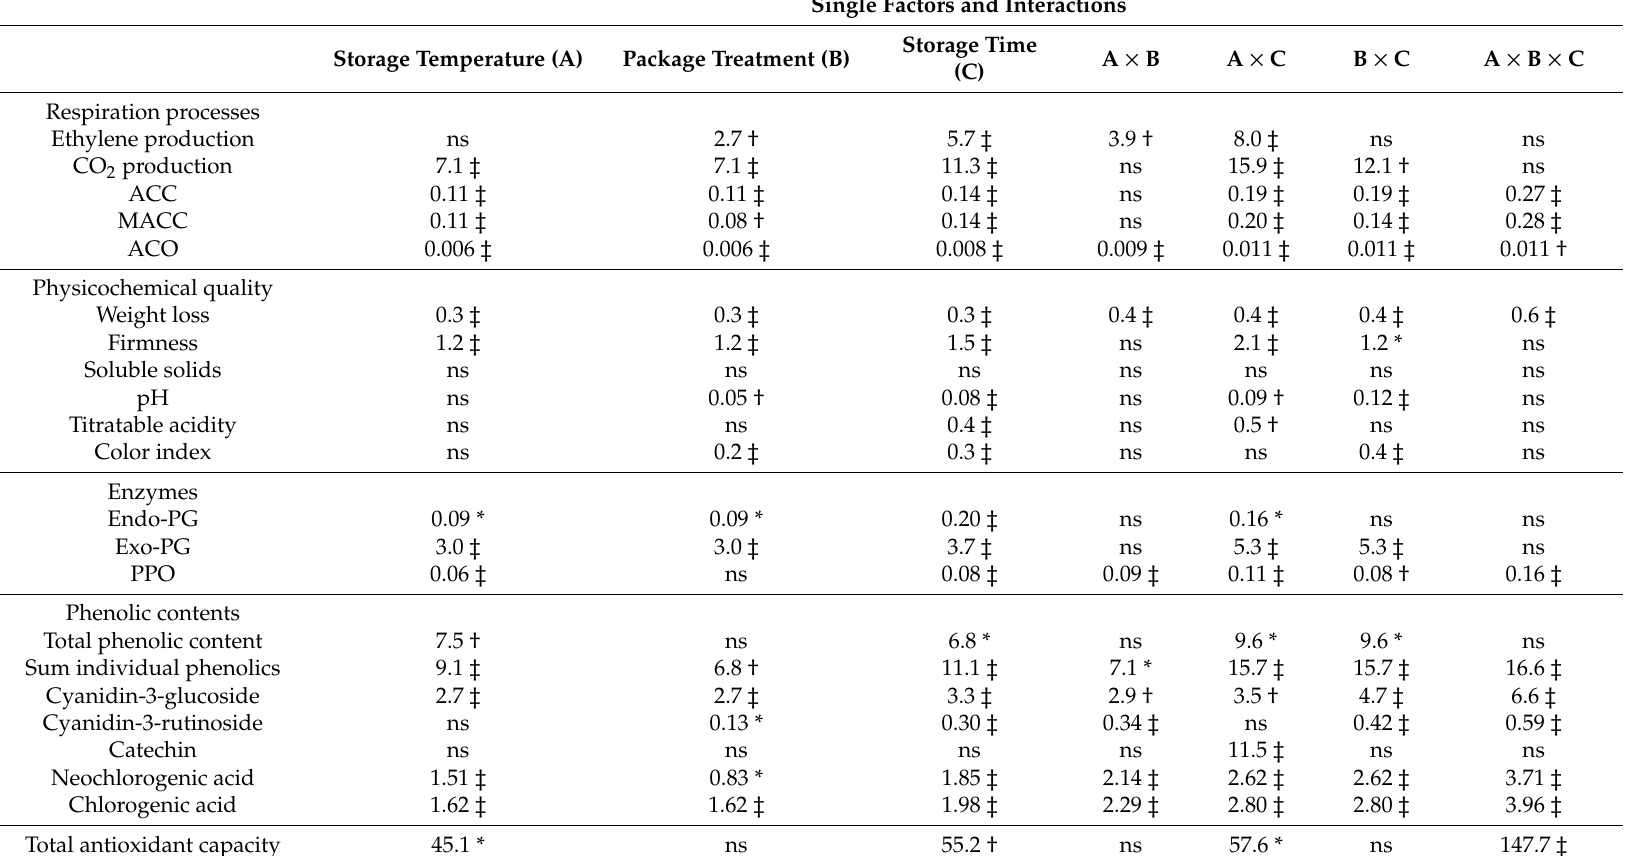
Table 1. Analysis of variance of parameters measured during cold storage periods (2 and 8 ◦ C) and complimentary commercialization simulations (4 days at 22 ◦ C) of flat peaches with or without active paper sheets (including β CD-encapsulated EOs). Values represent least significant di ff erences. ACC, 1-aminocyclopropanecarboxylic acid; MACC, N-malonyl-ACC; ACO, ACC oxidase; PG, polygalacturonase; PPO,